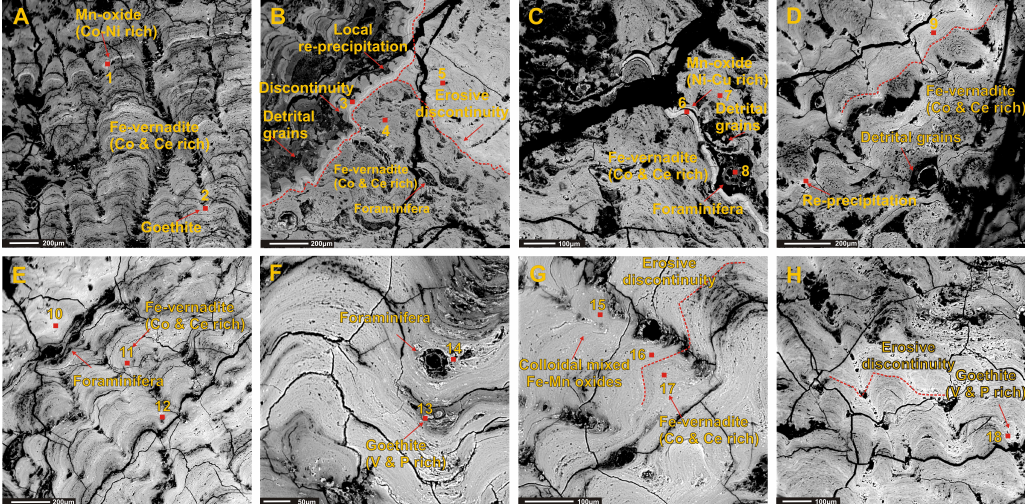
Figure 10. Thin polished-section EPMA photomicrographs (backscatter mode) with the location of microprobe analysis (see Supplementary Table 1), ( A – D ) Images of DR07-8 and ( E – H ) of DR16-13. ( A ) Dendritic branched morphology with thin Co–Ni Mn-oxide laminations ( B ) Discontinuity with change in accretion direction and erosive parallel discontinuity. ( C ) Diagenetic Ni–Cu-rich Mn-oxide forming thin lamination. ( D ) Nodular Fe–Mn re-precipitation and erosive parallel discontinuity. ( E ) Dense sub-parallel lamination englobing several foraminifera throughout the lamination. ( F ) Goethite-rich areas, with high contents of V and P, in the convergence of columns. ( G , H ) Erosive discontinuity clearly recognizable throughout the lamination and goethite-rich